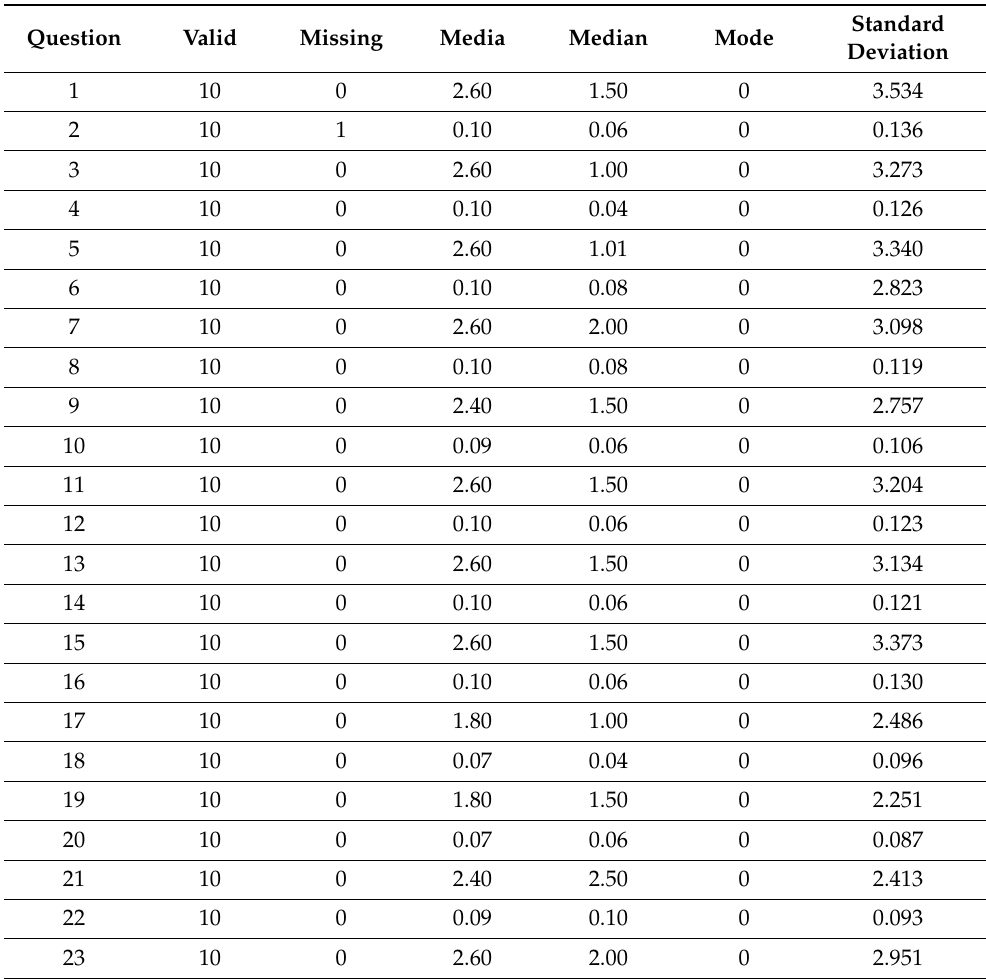
Table 1. CSD’s statistics.